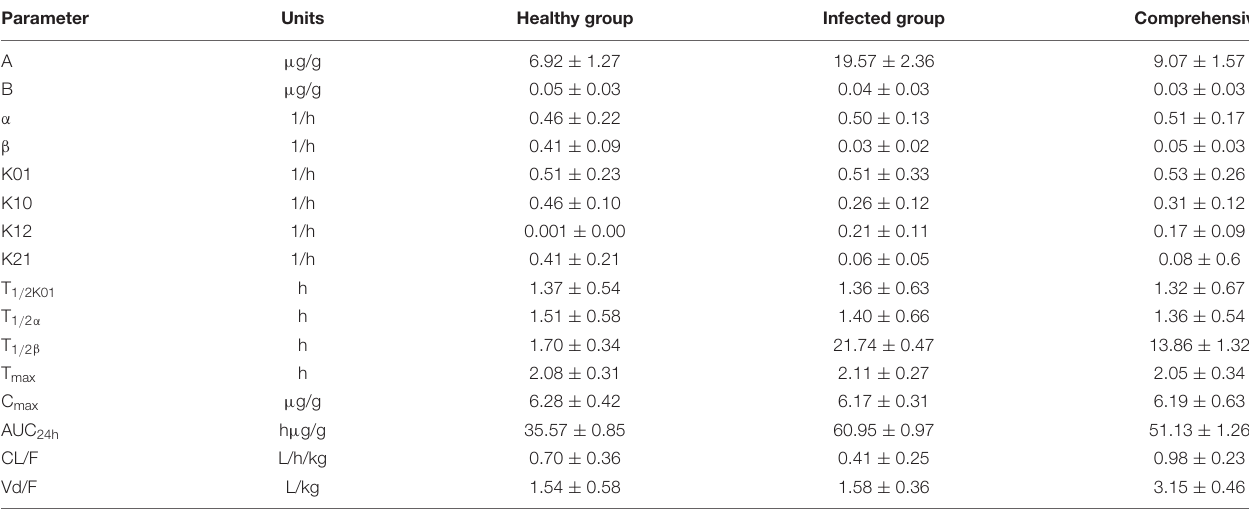
TABLE 2 | Lung tissue pharmacokinetic parameters of healthy and infected chickens after intragastric administration of 25 mg/kg b.w. tylosin. Parameter Units Healthy group